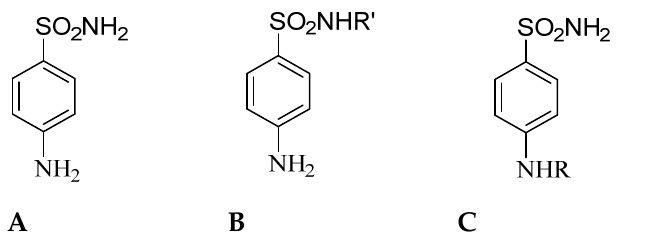
Figure 3. Sulfanilamide (Panel A ) led to the discovery of the sulfadrugs (Panel B ) and benzenesulfonamide CAIs of type (Panel C ).